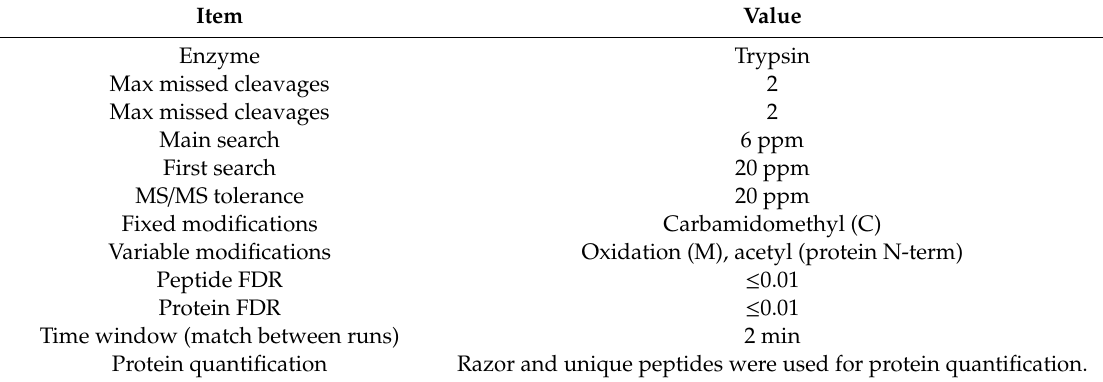
Table 3. The MaxQuant search library parameter settings.